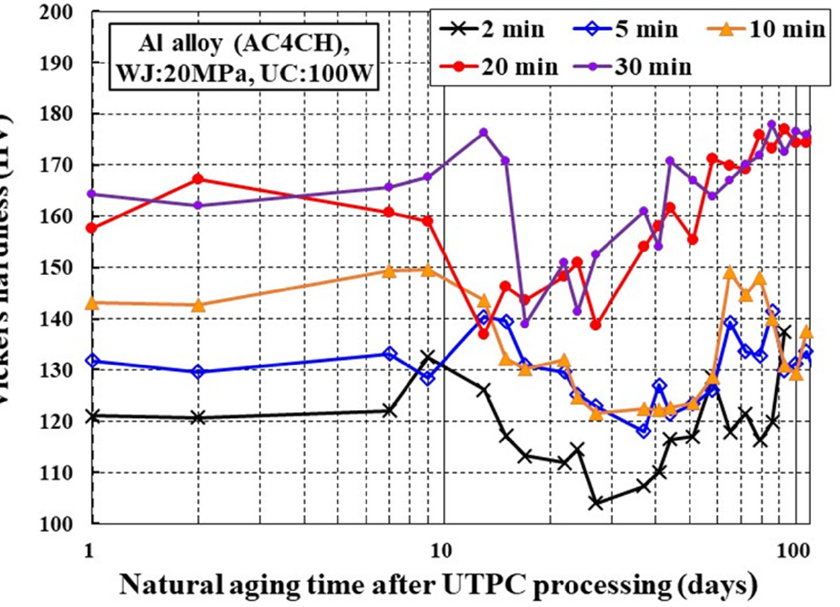
Figure 7. Relationship between hardness and elapsed time after LTPC processing. (WJ: 20 MPa, UC: 100 W) (Average of standard deviation: 2 min 7.7 HV, 5 min 6.6 HV, 10 min 8.5 HV, 20 min 8.4 HV, 30 min HV, 60 min 8.4 HV).